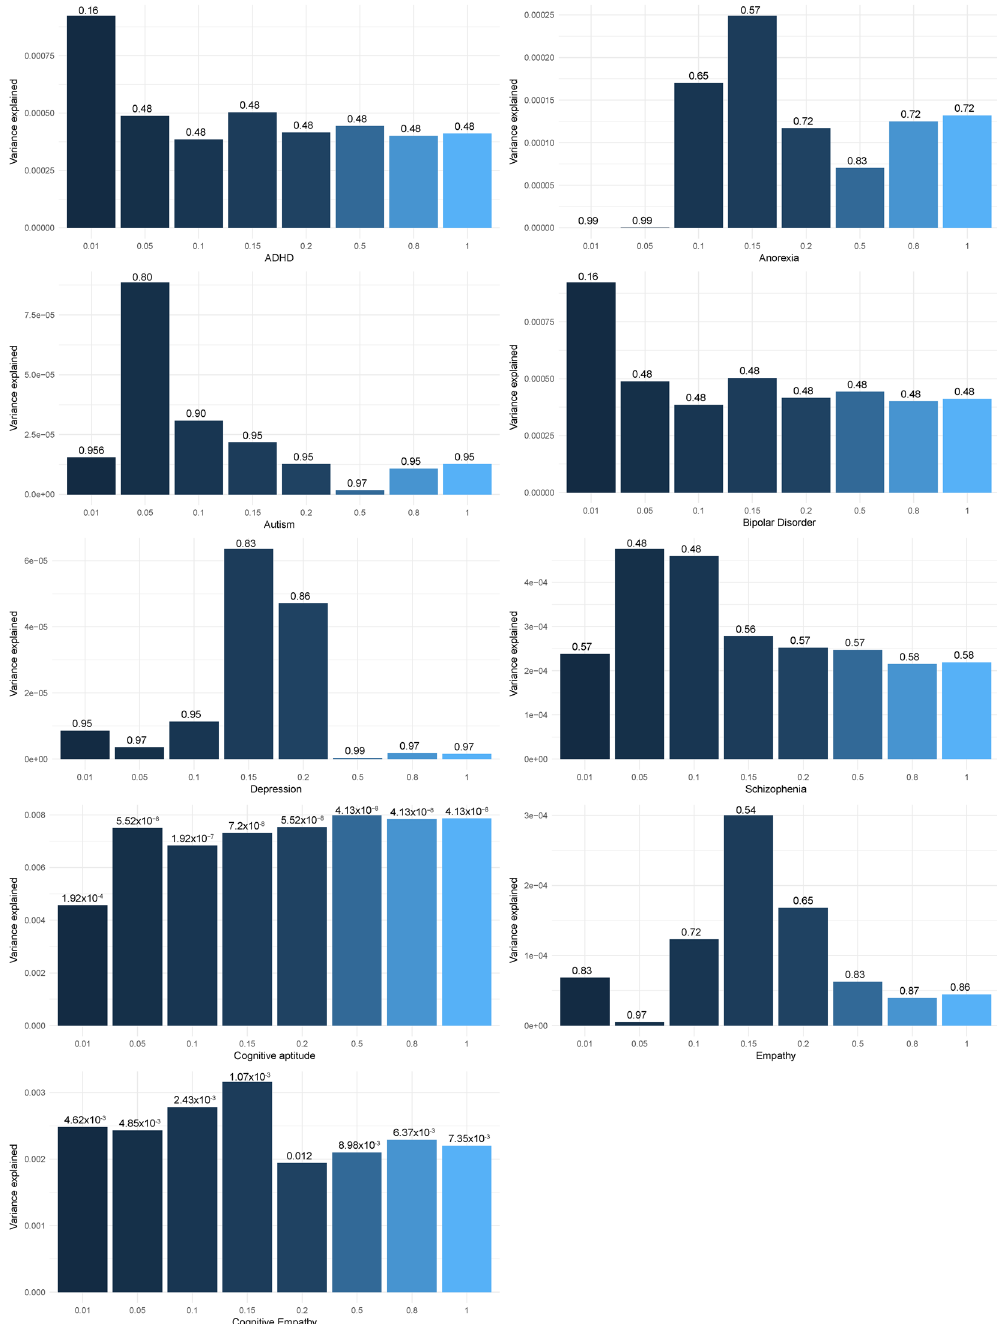
Figure 3. Polygenic score results at various P-value thresholds for the Triangles Task. Height of bars (Y-axis) represent the model fit (R 2 ). Numbers above bars represent P-values (FDR corrected). X-axis represents the 8 P-value thresholds. Names of the GWAS datasets provided under the bar